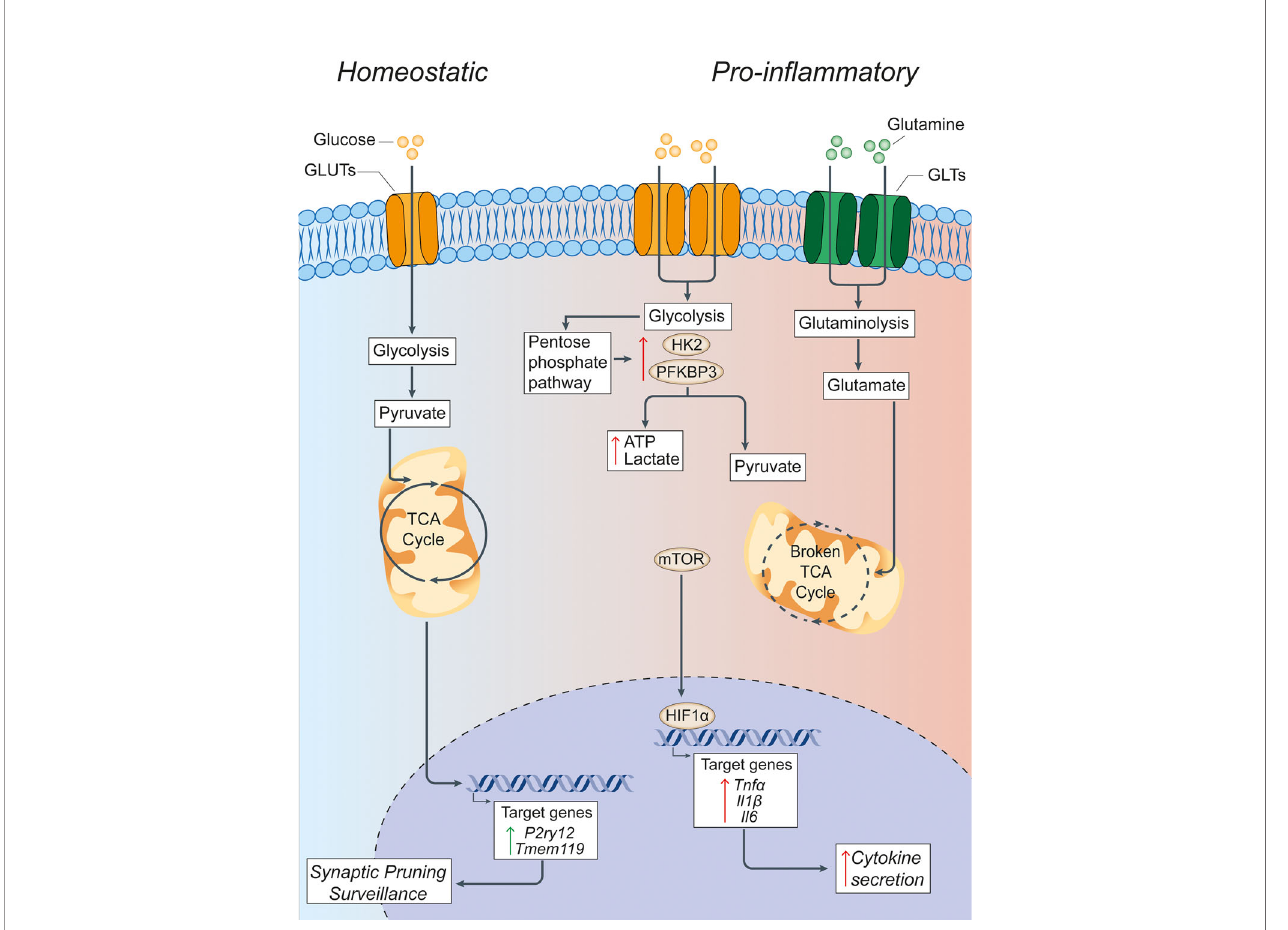
FIGURE 1 | Glucose metabolism in microglia under homeostatic and in fl ammatory conditions. Under homeostatic conditions, extracellular glucose is transported into microglial cells through specialized glucose transporters, where it is converted into pyruvate through cytoplasmic glycolysis. Pyruvate is then actively transported across the mitochondrial membrane to drive the TCA cycle. The energy and metabolites produced in the TCA cycle can then support the expression of the homeostatic microglial genes P2ry12 and Tmem119 , which facilitate microglial functions of synaptic pruning and immune surveillance. In pro-in fl ammatory conditions, microglia have a broken TCA cycle and increase the expression of membrane transporters to facilitate the uptake of glucose and glutamine, thus driving enhanced glycolysis and glutaminolysis. Glycolysis is supported by increased expression of the rate-limiting enzymes of glycolysis HK2 and PFKBP3. This leads to the increased generation of lactate and ATP to compensate for the broken TCA cycle, and shunting of metabolites into the pentose phosphate pathway. The increased glycolysis is sustained by the activation of nuclear transcription factors HIF1 a and mTOR that support the synthesis and production of cytokines for secretion. Green arrows = homeostatic effects. Red arrows = pro-in fl ammatory effects. GLUT, glucose transporter; TCA, tricarboxylic acid cycle; GLT, glutamate transporter; HK2, hexokinase 2; PFKBP3, 6-phosphofructo-2-kinase/fructose-2,6-biphosphate-3; HIF1 a , hypoxia inducible factor 1 a ; ATP, adenosine triphosphate; mTOR, mechanistic target of rapamycin; TNF a , tumor necrosis factor alpha; Il1 b , interleukin-1 b ; Il6,